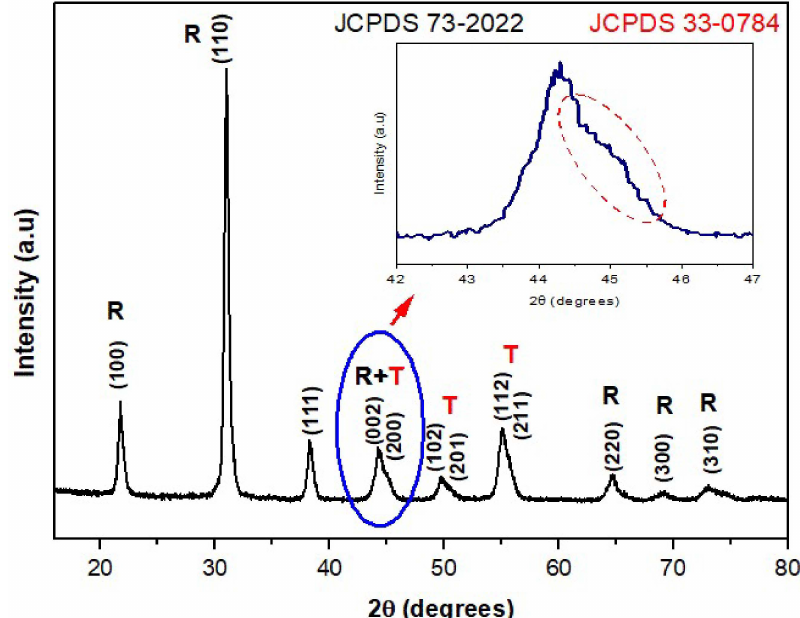
Figure 4. Pattern of diffraction of X-ray for PZT particles obtained via Pechini’s method, highlight- ing the typical superposition due to the coexistence of tetragonal (T) (JCPDS file n o 33-0784) and rhombohedral (R) (JCPDS file n o 73-2022) phases at the morphotropic phase boundary